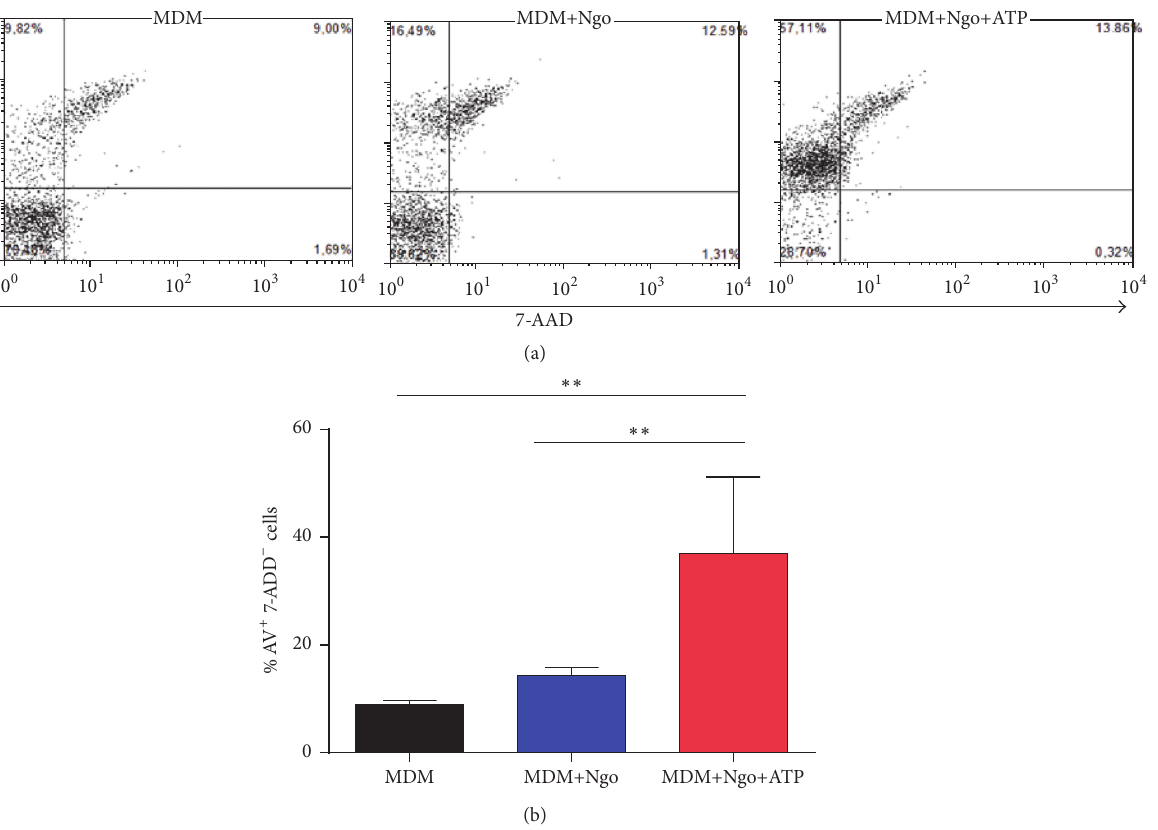
Figure 4: ATP treatment is able to increase apoptosis in Ngo-infected MDM. FITC Annexin V with 7-AAD staining was performed and the MDM population was determined by flow cytometry. (a) Representatives dot plot from one assay are shown. (b) Percentage of positive AnnexinVand7-AADcellsunderdifferentconditions.Dataobtainedareexpressedasthemean ± SDandrepresentatleastthreeindependent experiments. ∗∗ 𝑃 < 0.01